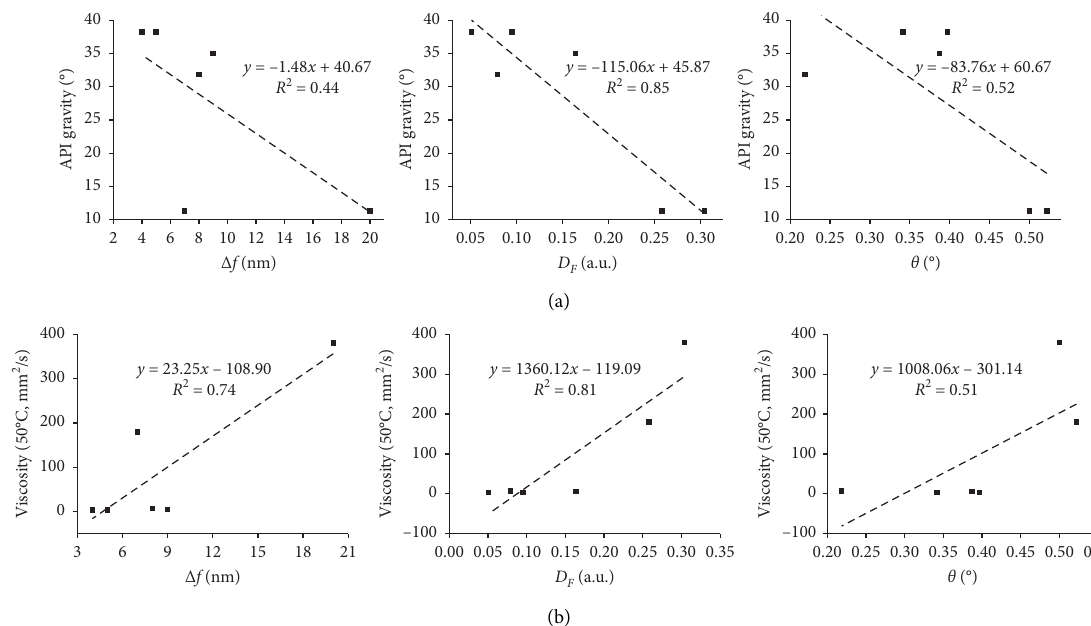
Figure 5: Correlation analysis of the relationship between the (a) API gravity and (b) viscosity of the six oil samples and the main peak position ( Δ f), fluorescence intensity distance ( D F ), and generalized included angle cosine ( θ Table 4: Contribution of eight AH series in Kuwait crude, Iranian crude, 180# fuel, 380# fuel, 0# diesel, and − 10# diesel oil samples. Kuwait crude oil